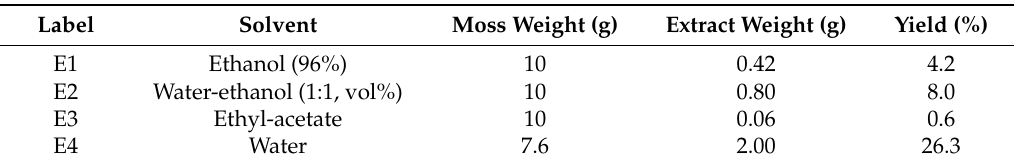
Table 1. Extraction yield for Hypnum cupressiforme extracts.